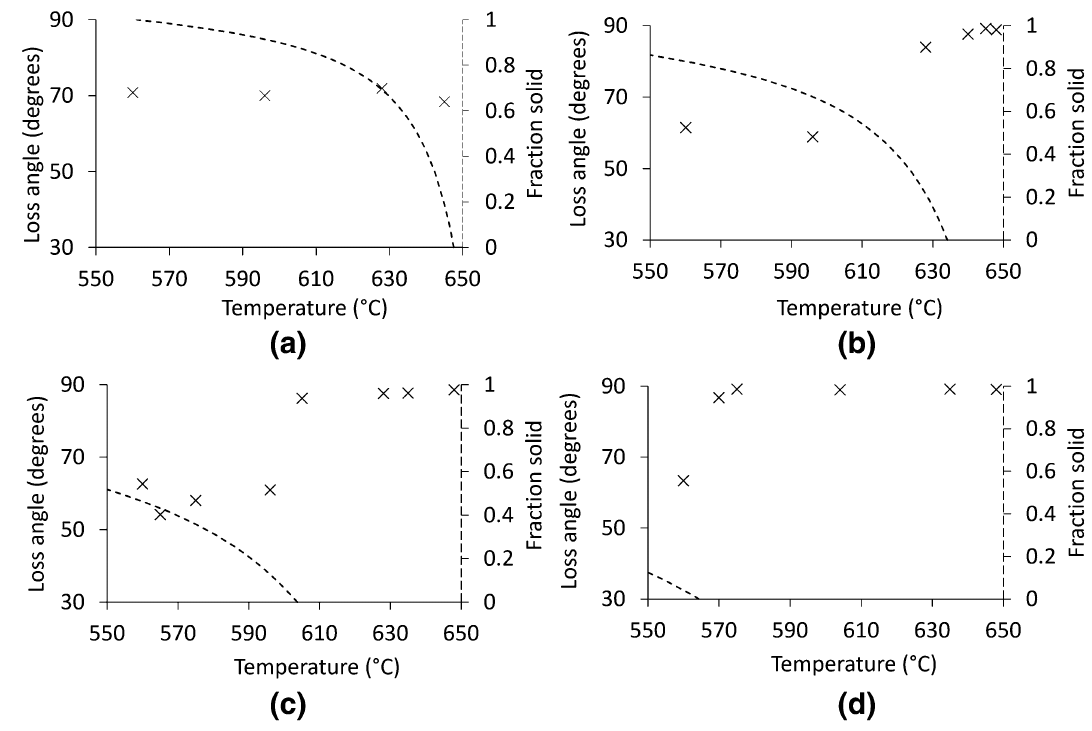
Fig. 8 Loss angle δ for the oscillatory measurements in Fig. 5- a 5%, b 10%, c 20% and d 30% (by weight)